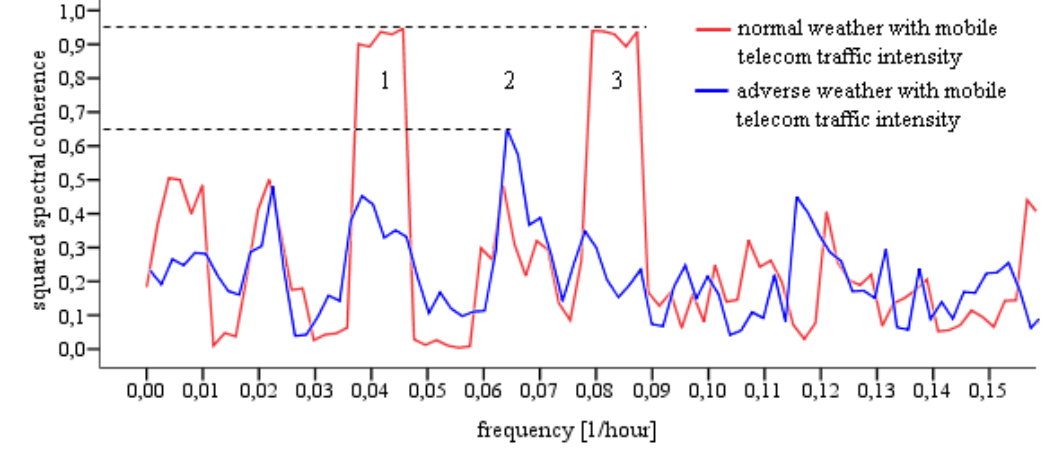
Figure 3. Spectral correlation of normal and adverse weather conditions with telecom traffic